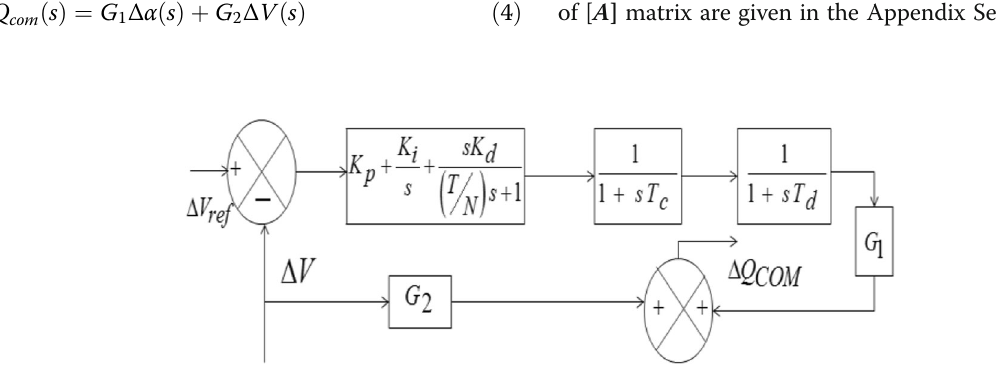
Here, A and B are the system state square matrix and the control matrix, respectively. The various parameters ð 4 Þ of [ A ] matrix are given in the Appendix Section.